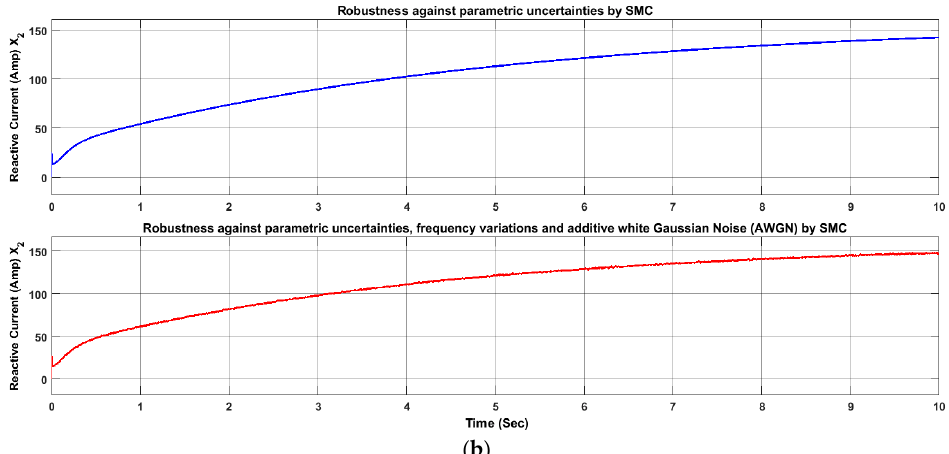
Figure 15. ( a ) d-axis current comparison; ( b ) q-axis current comparison, between robustness analysis against parametric variation and robustness analysis against parametric uncertainties, frequency variation and additive Gaussian noise using SMC control technique based on boundary conditions.